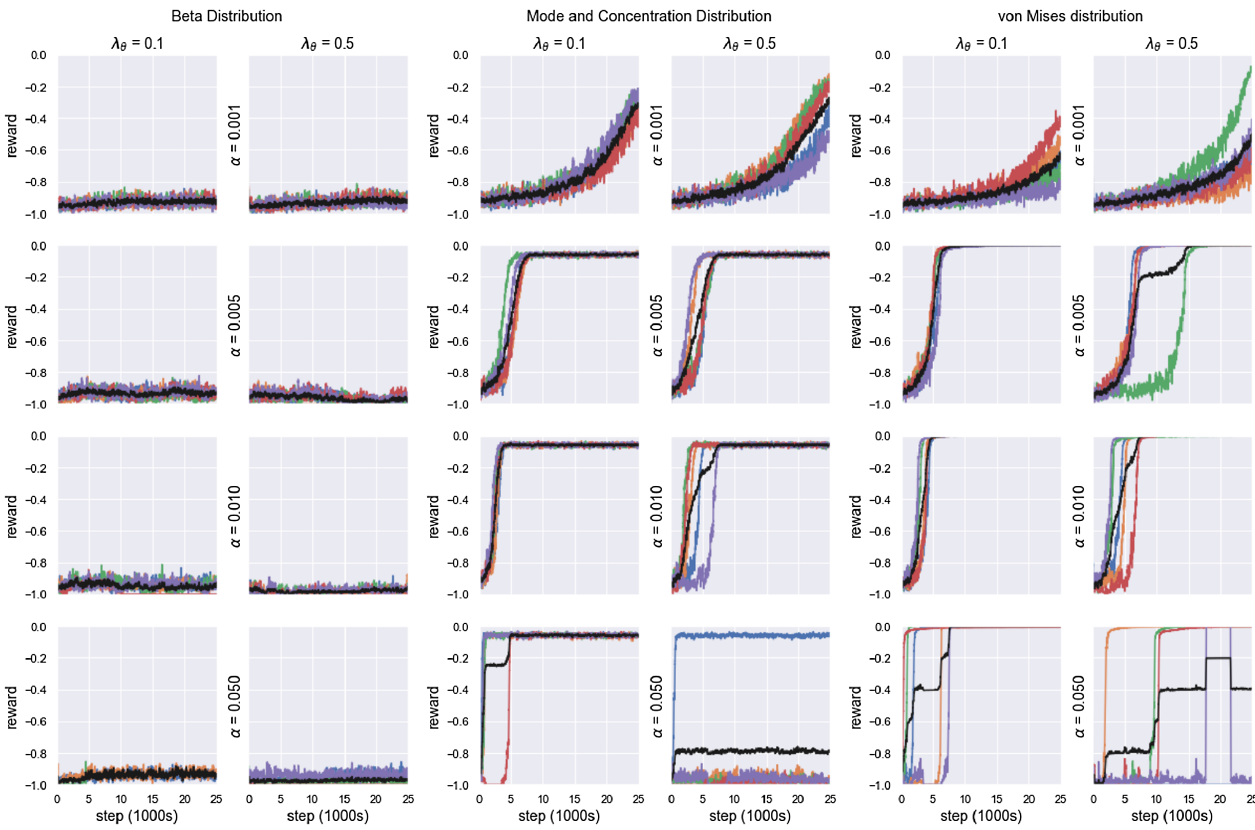
FIG. 3. Plot of the reward received by the agent versus step number. For this task the agent must “ guess ” the number − 3 . 5 . The standard deviation of the reward is 0.1. The agent begins the task with mode − 2 . 5 and standard deviation 1.0. For each of the three agent types, we varied the eligibility trace memory parameter, λ θ , and the learning rate, α , as shown in the figure. For each setting 5 trials (represented by the colored lines) were performed and the task was ended after 25,000 steps. A 100-step rolling average was performed to smooth the plots for ease of comparison. The black line is the average of all 5 trials in each